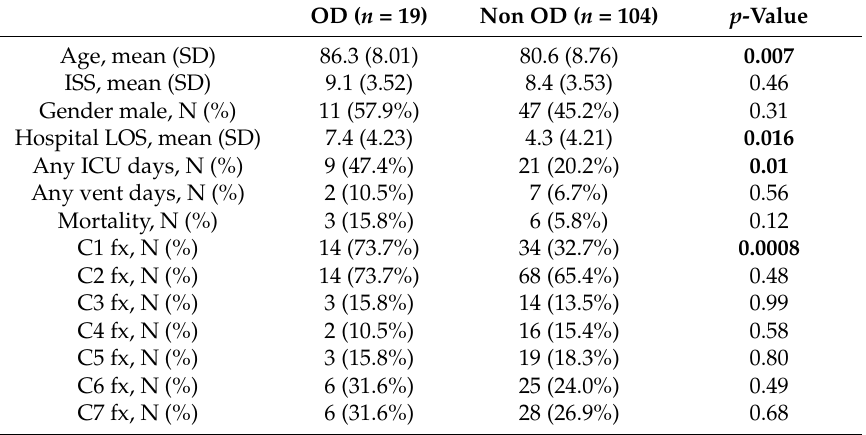
Table 4. Comparison of dysphagia by level of C spine fracture in a non-operative